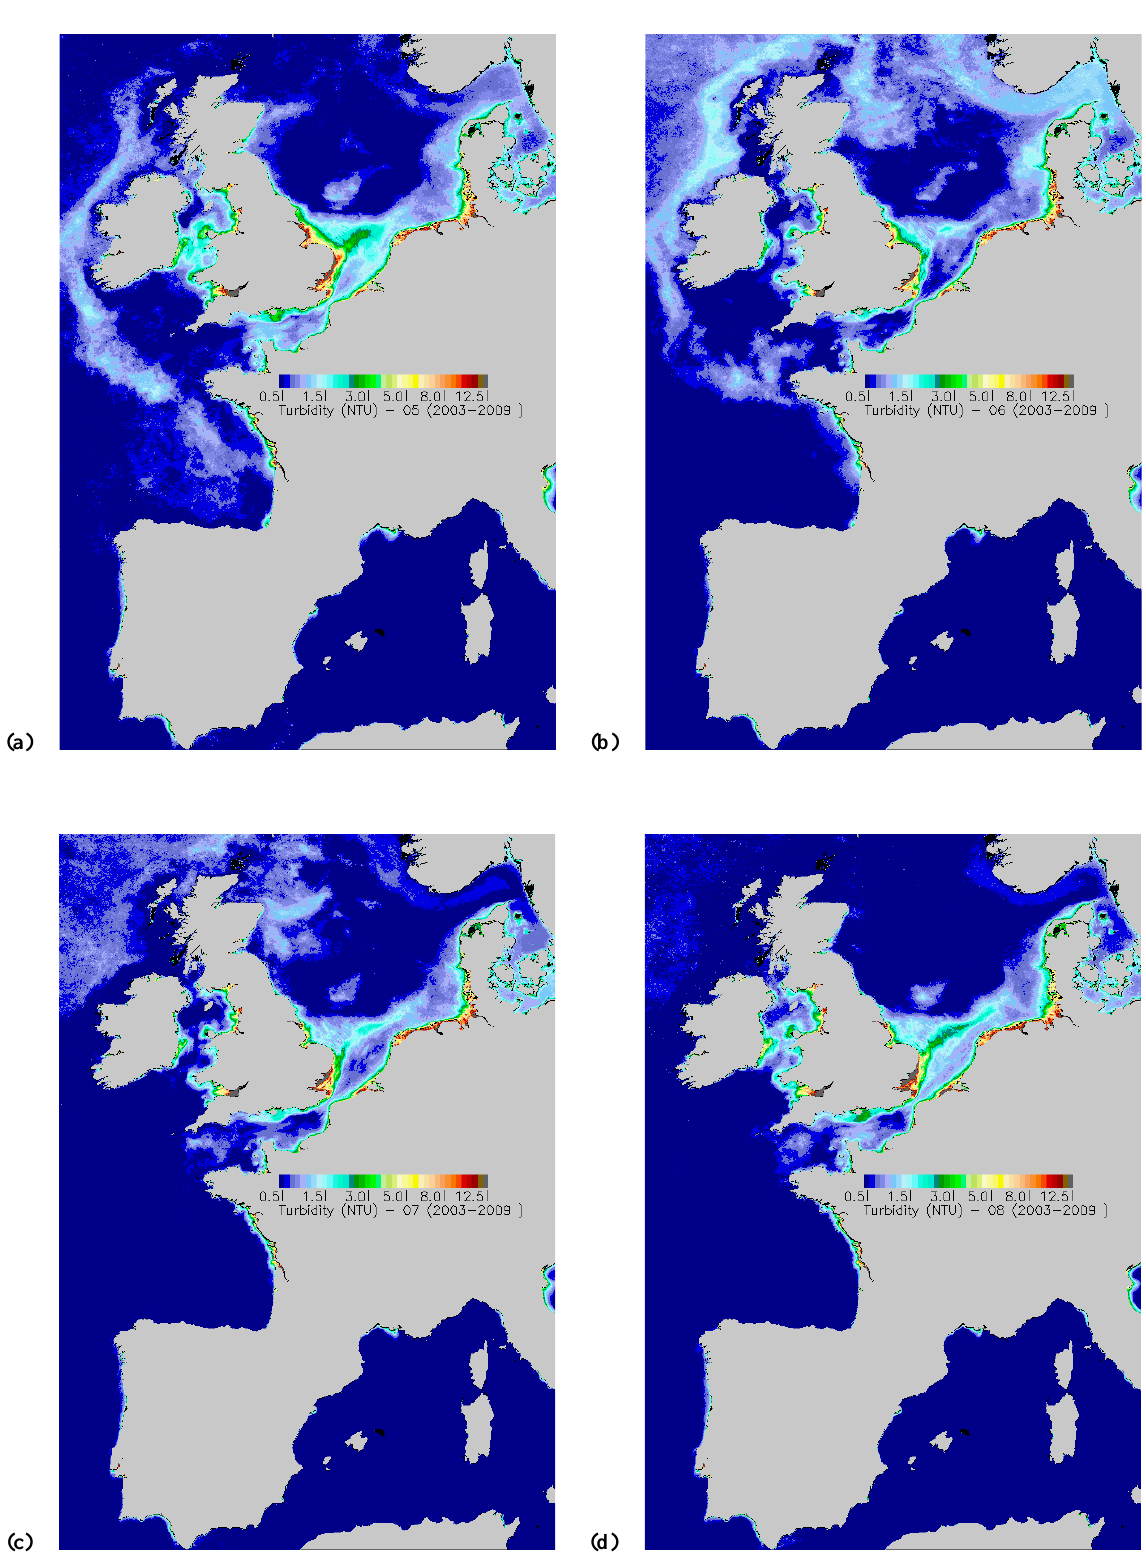
Fig. C2. Monthly turbidity in May (a) , June (b) , July (c) and August (d)